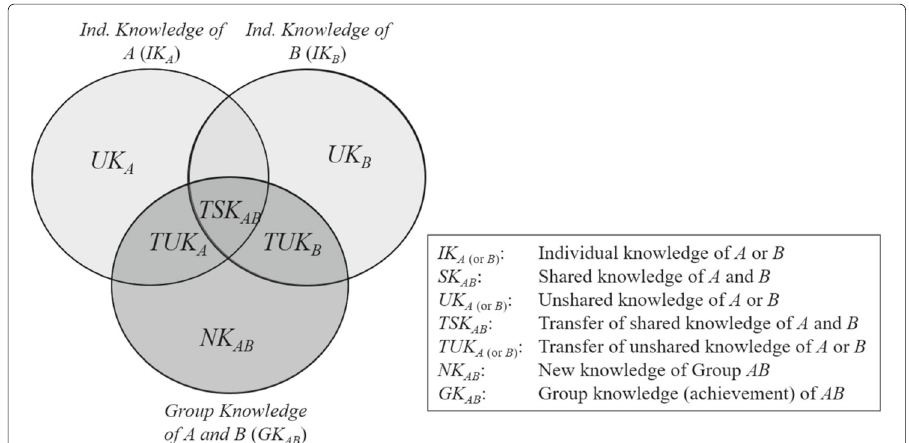
Fig. 3 Illustration of learning effectiveness